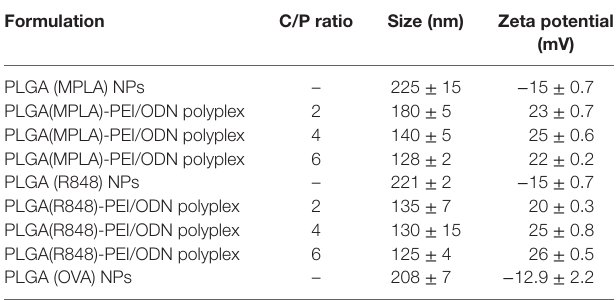
TaBle 2 | Characterization of MPLA-loaded, R848-loaded, and OVA-loaded PLGA/PEI core–shell co-polymer formulations containing CpG ODN. Formulation c/P ratio